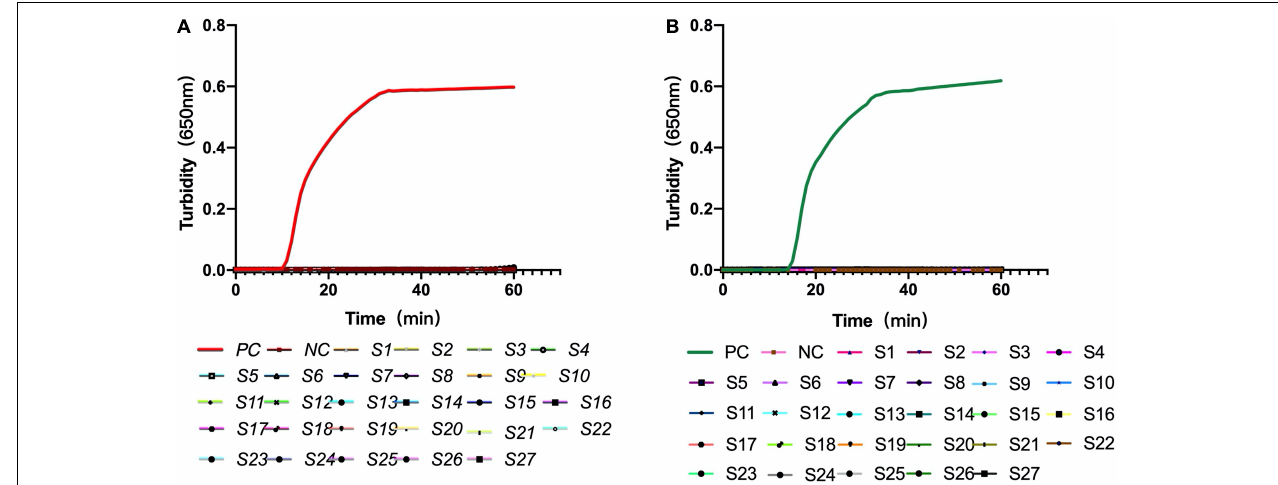
FIGURE 4 | Specificity of the loop-mediated isothermal amplification assay for S. pneumoniae detection. (A) Specificity of the LAMP assay with primer set LytA-1 targeted the lytA gene. (B) Specificity of the LAMP assay with primer set PsaA-2 targeted the psaA gene. The detection was monitored by turbidity using a Loopamp real-time turbidimeter. S1: influenza A, S2: influenza B, S3: parainfluenza viruses, S4: adenoviruses, S5: respiratory syncytial virus, S6: human metapneumovirus, S7: human bocavirus, S8: rhinovirus, S9: Mycoplasma pneumoniae M129, S10: Mycoplasma pneumoniae FH, S11: Haemophilus influenzae , S12: Legionella pneumophila , S13: Listeria monocytogenes , S14: Staphylococcus aureus , S15: Klebsiella pneumoniae , S16: Pseudomonas aeruginosa , S17: Escherichia coli , S18: Acinetobacter baumannii , S19: Mycobacterium tuberculosis , S20: Bordetella pertussis , S21: Streptococcus mitis , S22: Streptococcus oralis , S23: Streptococcus agalactiae , S24: Streptococcus mutans , S25: Streptococcus parasanguinis , S26: Streptococcus sanguinis , S27: Streptococcus